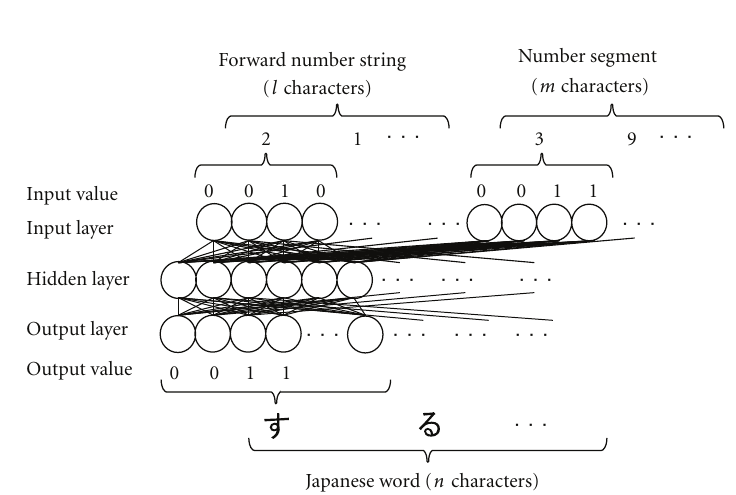
Figure 8: Structure of